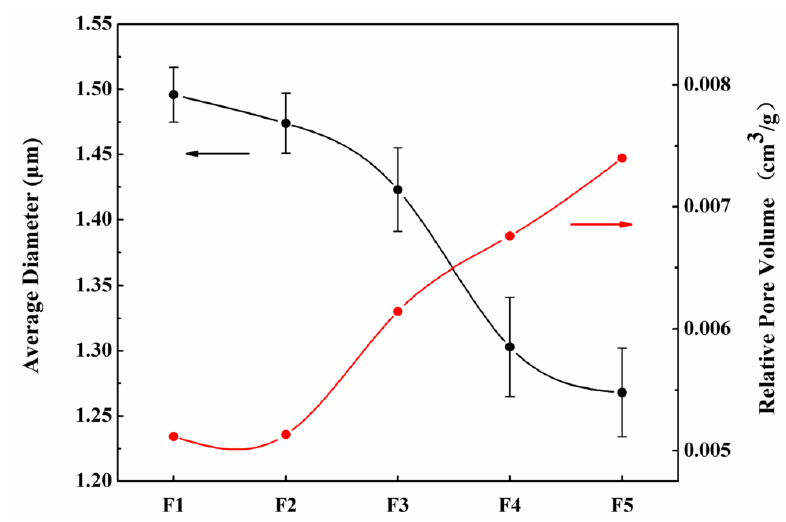
Figure 2. Average fiber diameters (black line) and relative pore volumes (red line) of porous fibers obtained using different needle diameters.